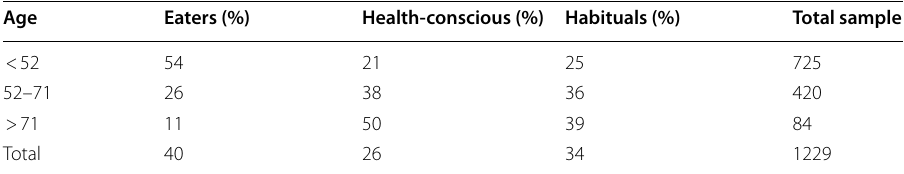
Table 7 Sociodemographic percentage differences of the clusters: age